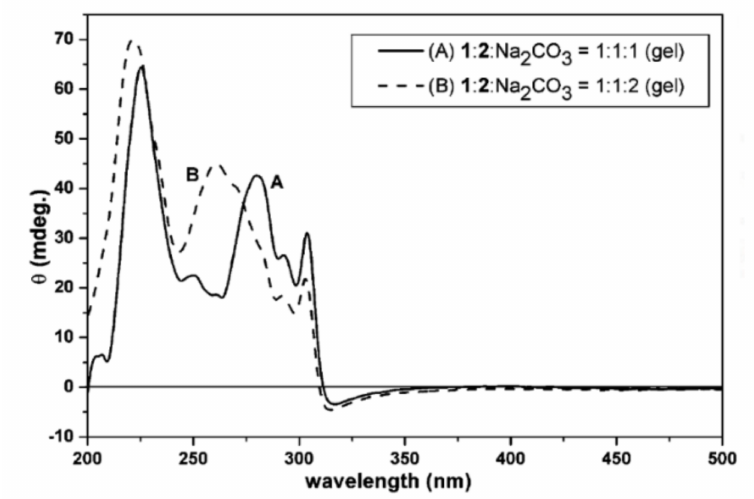
Figure 3. CD spectra of hydrogels prepared from N -fluorenylmethoxycarbonyl (Fmoc)-protected amino acids, NPC 15199 and a lysine derivative, with differing concentrations of Na 2 CO 3 . Repro- duced with permission from [42] ©2004, Royal Society of